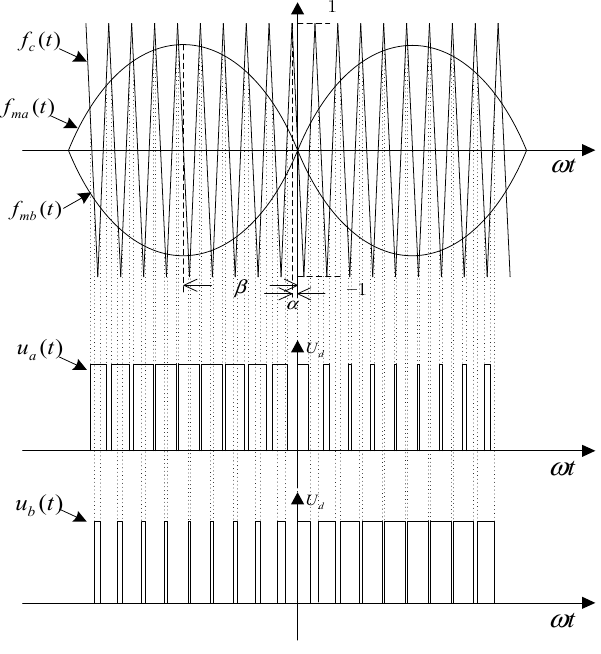
Figure 3. Two-level 4QC modulation principle.